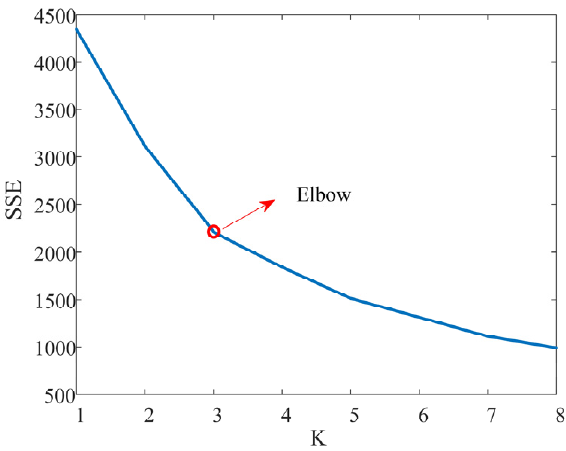
Figure 4. SSE-K curve obtained by elbow method.